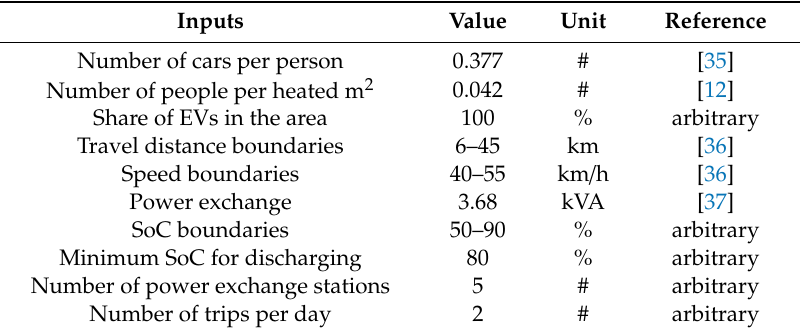
Table 2. Inputs to the in-house EVs’ driving profile model. Soc: state of charge. Inputs Value Unit